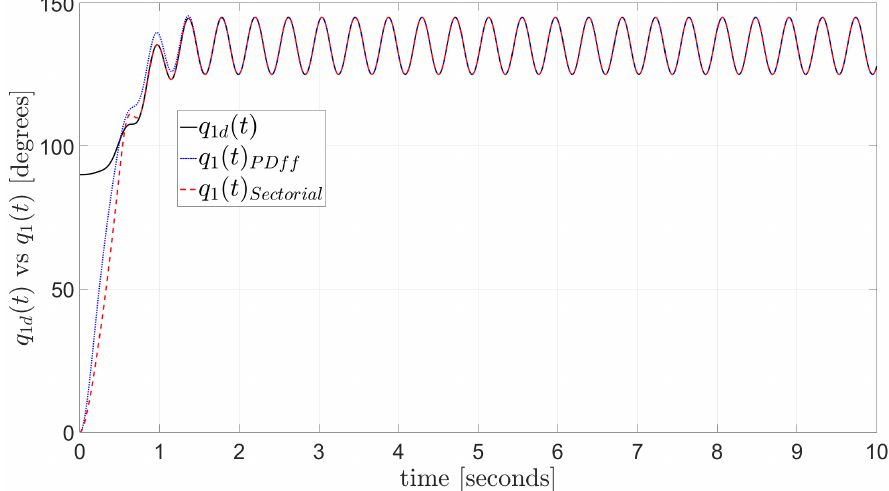
Figure 13. Desired vs. actual position in joint 1, without Coulomb